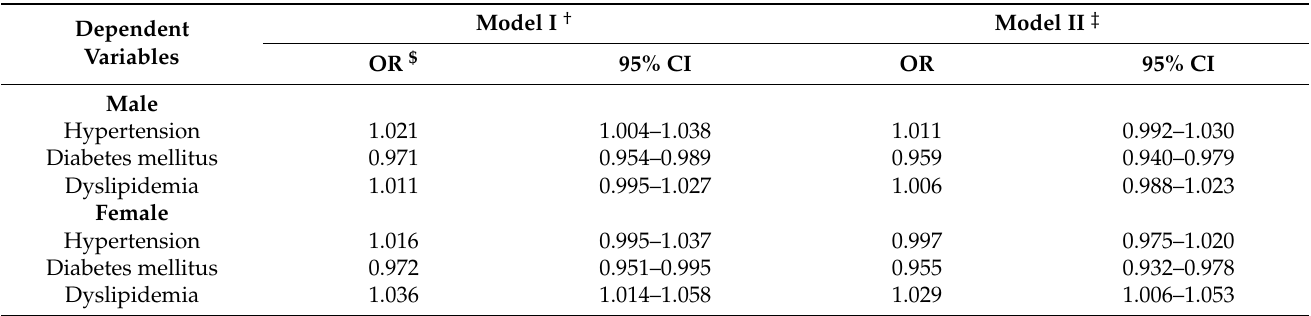
Table 4. Multivariate logistic regression analyses of grip strength on cardiometabolic diseases in different models with sex